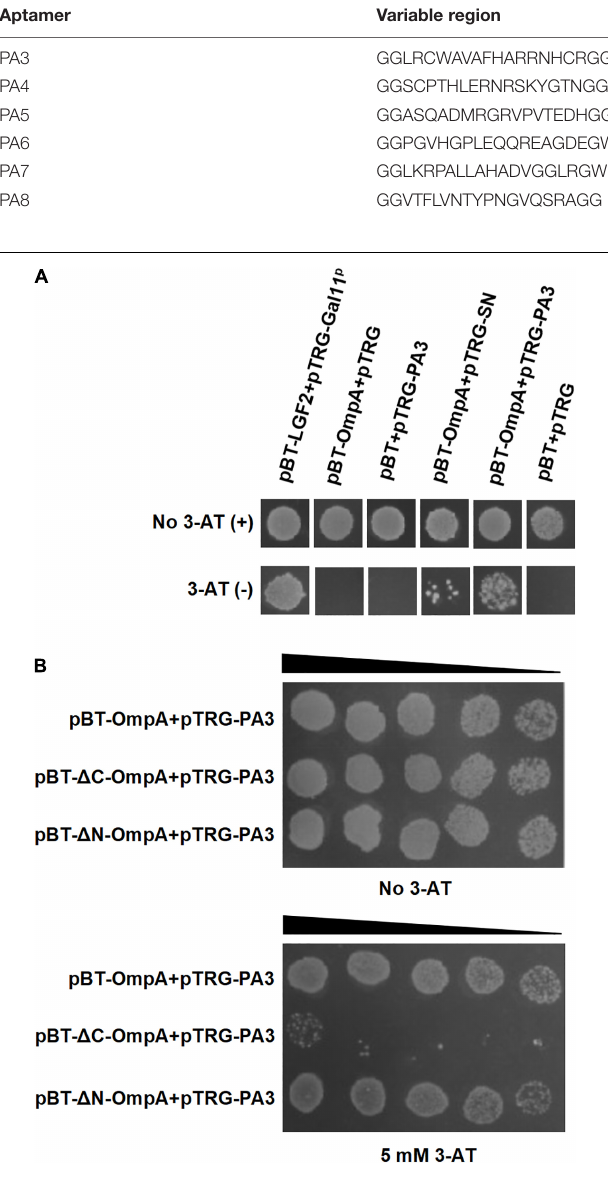
FIGURE 4 | Interaction between OmpA and the specific peptide aptamer PA3. (A) The co-transformants were cultivated overnight and were spotted onto no 3-AT or 5-mM 3-AT media with 10 µ l of 10 6 CFU/ml. (B) Identification of the key regions of OmpA interacting with PA3 by the bacterial two-hybrid